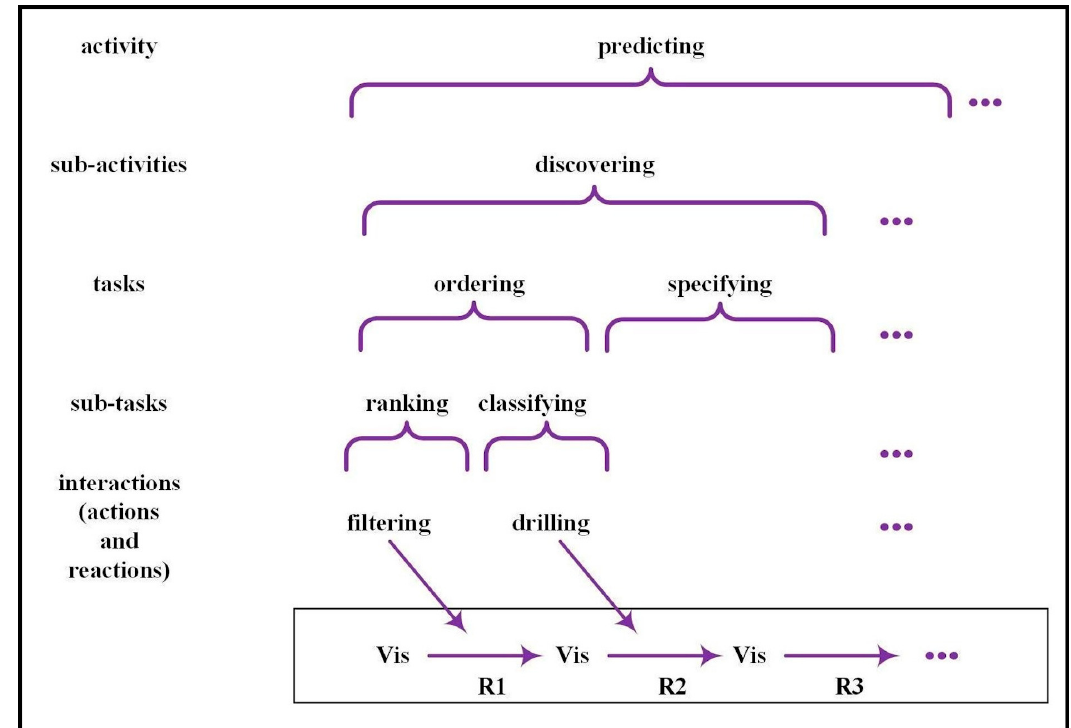
Figure 1. Relationships among activities, tasks, and interactions. Top-down view: activity is made up of sub-activities, tasks, sub-tasks, and interactions. Bottom-up view: activity emerges over time, through performance of tasks and interactions. Visualizations are depicted as Vis and reactions as R x . Source: adapted from [7].